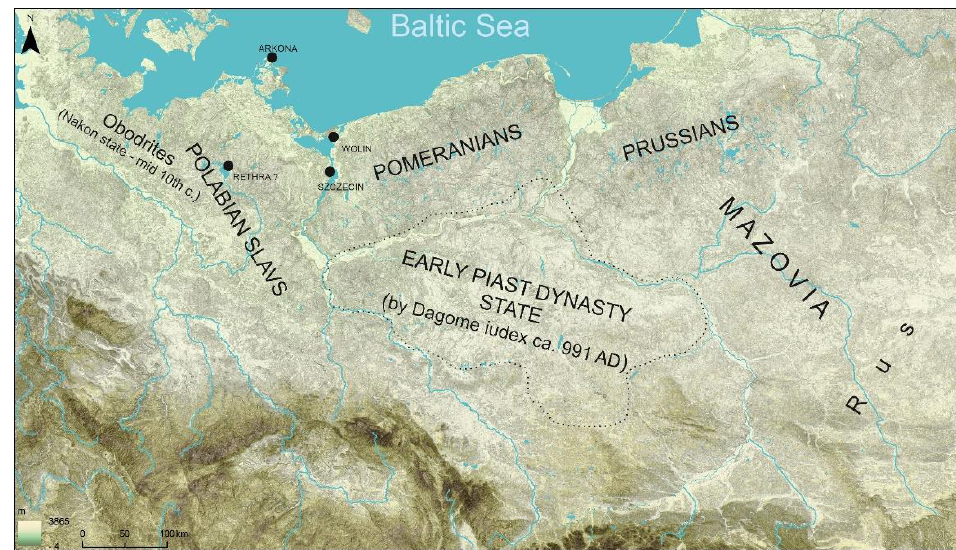
Figure 1. Historical regions of Western Slavs (ca. mid-10th – early 12th c.), their neighbours and the main Slavic cult temples mentioned in historical records (prepared by D. Makowiecki, drawing M. Skrzatek).